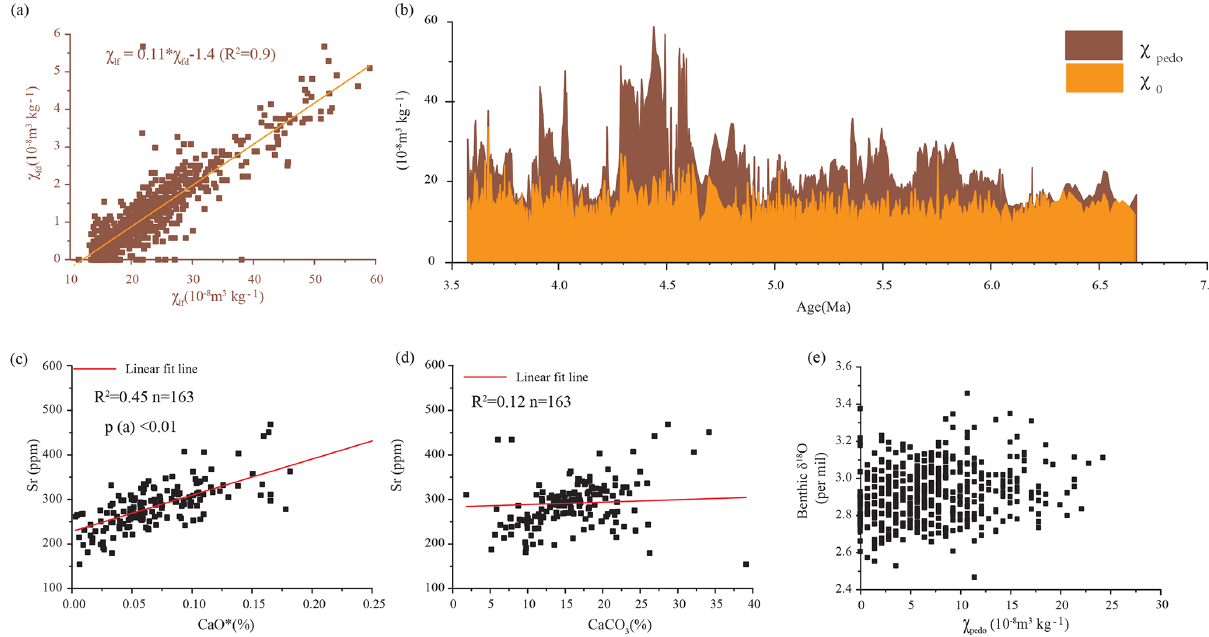
Figure 4. (a) Scatterplot of χ lf versus χ fd . (b) Separation of χ pedo and χ 0 . (c) Scatterplot of Sr versus CaO ∗ . (d) Scatterplot of Sr versus CaCO 3 . (e) Scatterplot of benthic δ 18 O versus χ pedo during 6.7–5.2Ma. χ pedo is the magnetic susceptibility of pedogenic origin and χ 0 is the magnetic susceptibility of the detrital